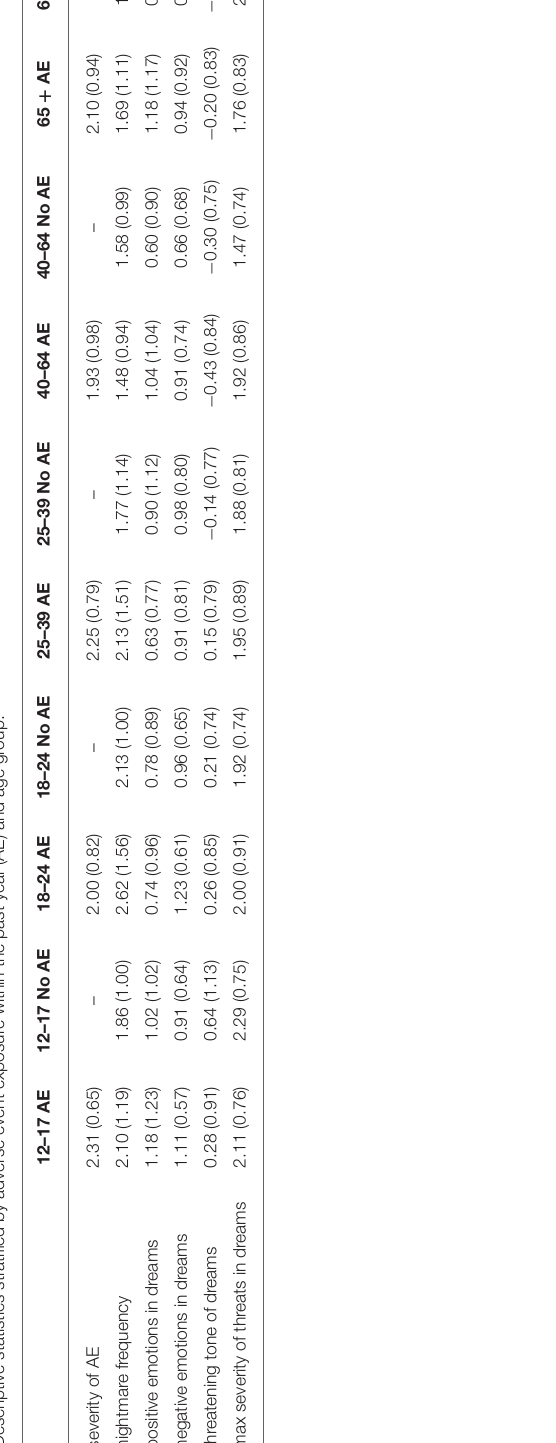
FIGURE 1 | Age group differences in the threatening tone of dreams. The values are expressed as means ± SEM, N = 255. ** p < 0.01, *** p < 0.001.